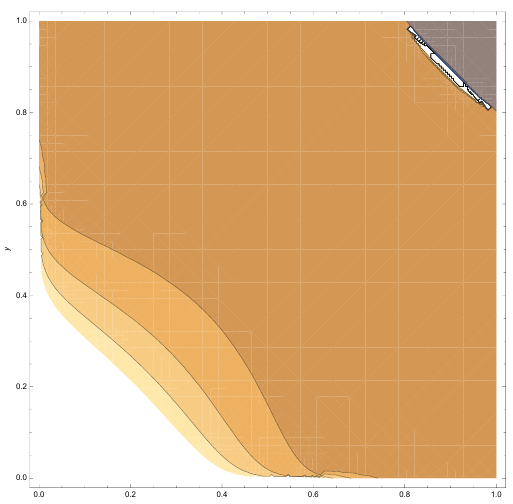
Figure A7. The bivariate Kumaraswamy density (Equation (1)) plot, where α = 0.5, β = 0.8, θ = 1.2 and δ = 3.